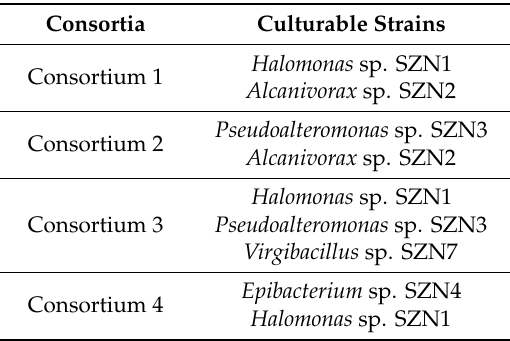
Table 1. Bacterial composition of the four